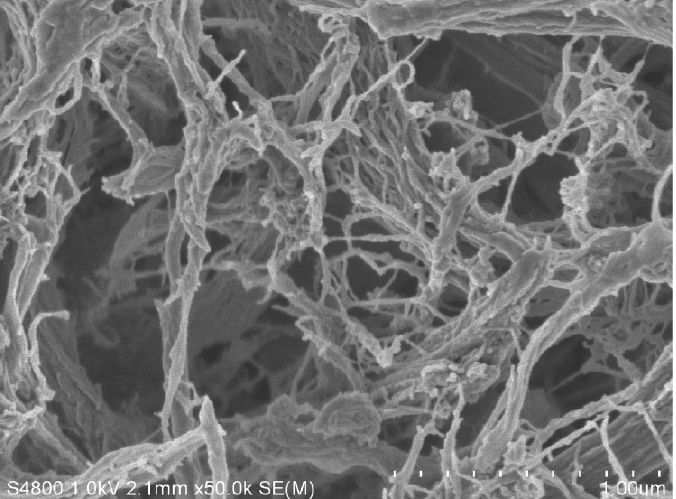
Figure 1. Scanning electron micrographs of the lignocellulose